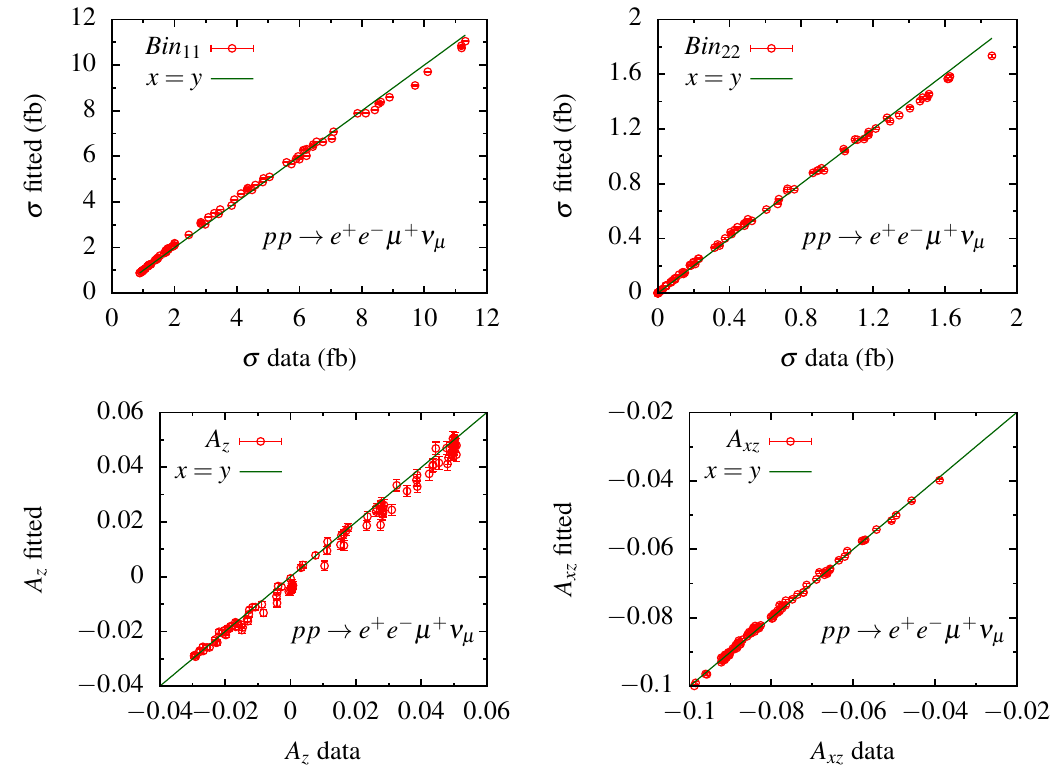
Figure 13 . The simulated data (in x -axis) vs. (cid:12)tted values (in y -axis) for the cross section in the two diagonal bins ( top-panel ) and the polarization asymmetries A z and A xz ( bottom-panel ) in in ZW + production in e + e (cid:0) (cid:22) + (cid:23) (cid:22) channel at the LHC at p s = 13